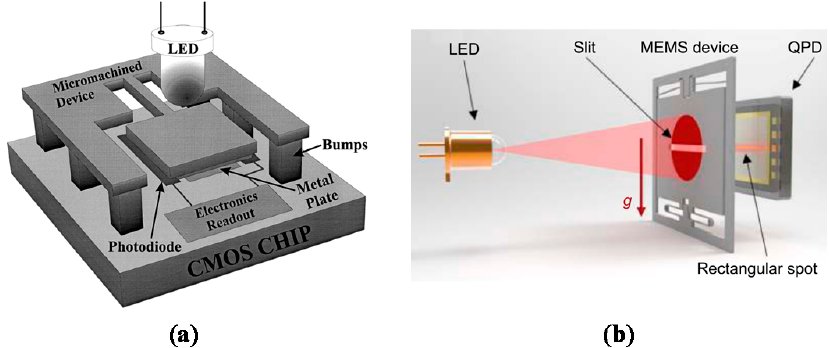
Figure 11. OSS-based accelerometer: ( a ) cantilevered and ( b ) asymmetric spring. Figures are reprinted